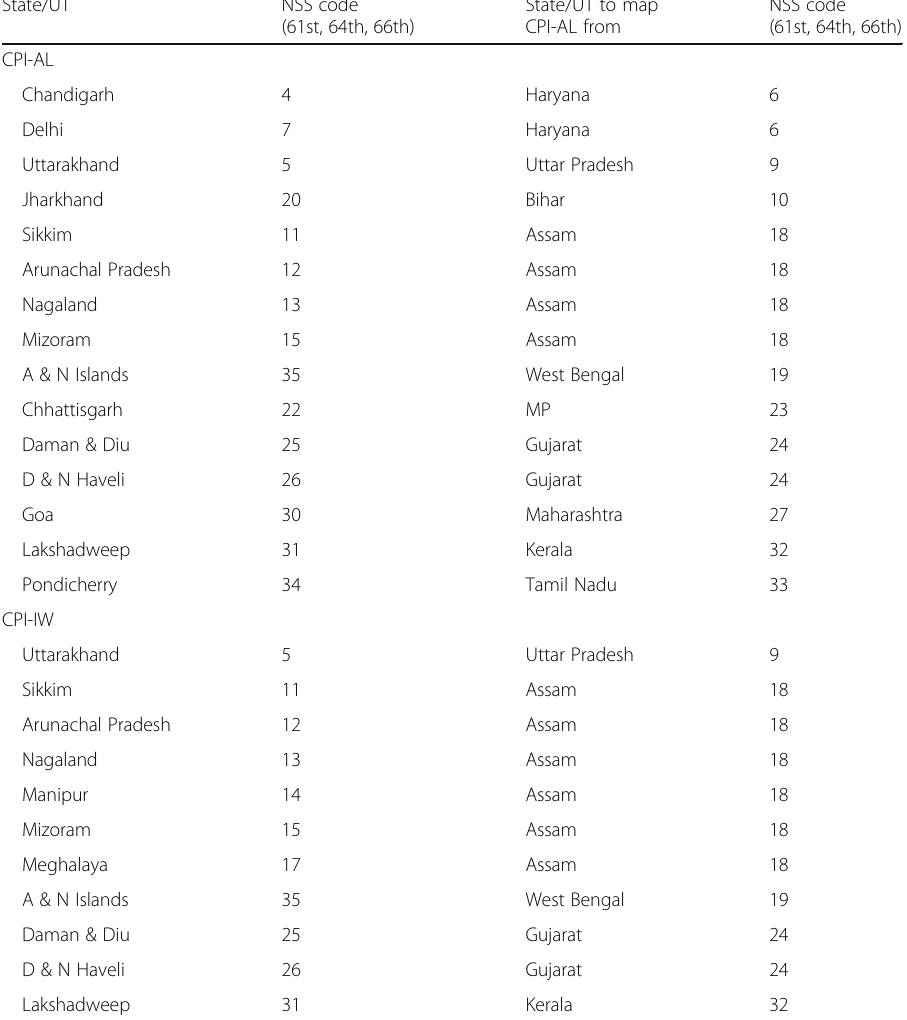
Table 5 Adjustment of consumer price index for small states